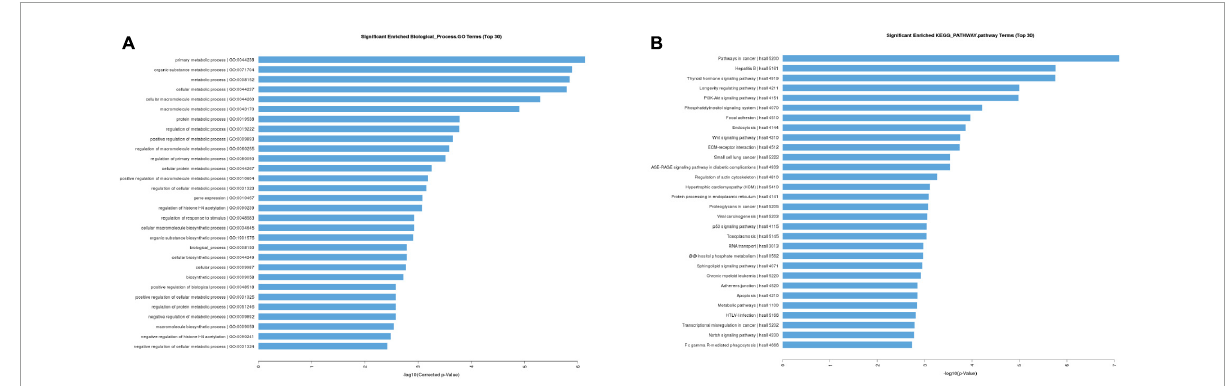
FIGURE2 Gene ontology (GO) and kyoto encyclopedia of genes and genomes (KEGG) enrichment analysis. (A) Top 30 classes of biological process enrichment terms. (B) Top 30 KEGG pathway terms.